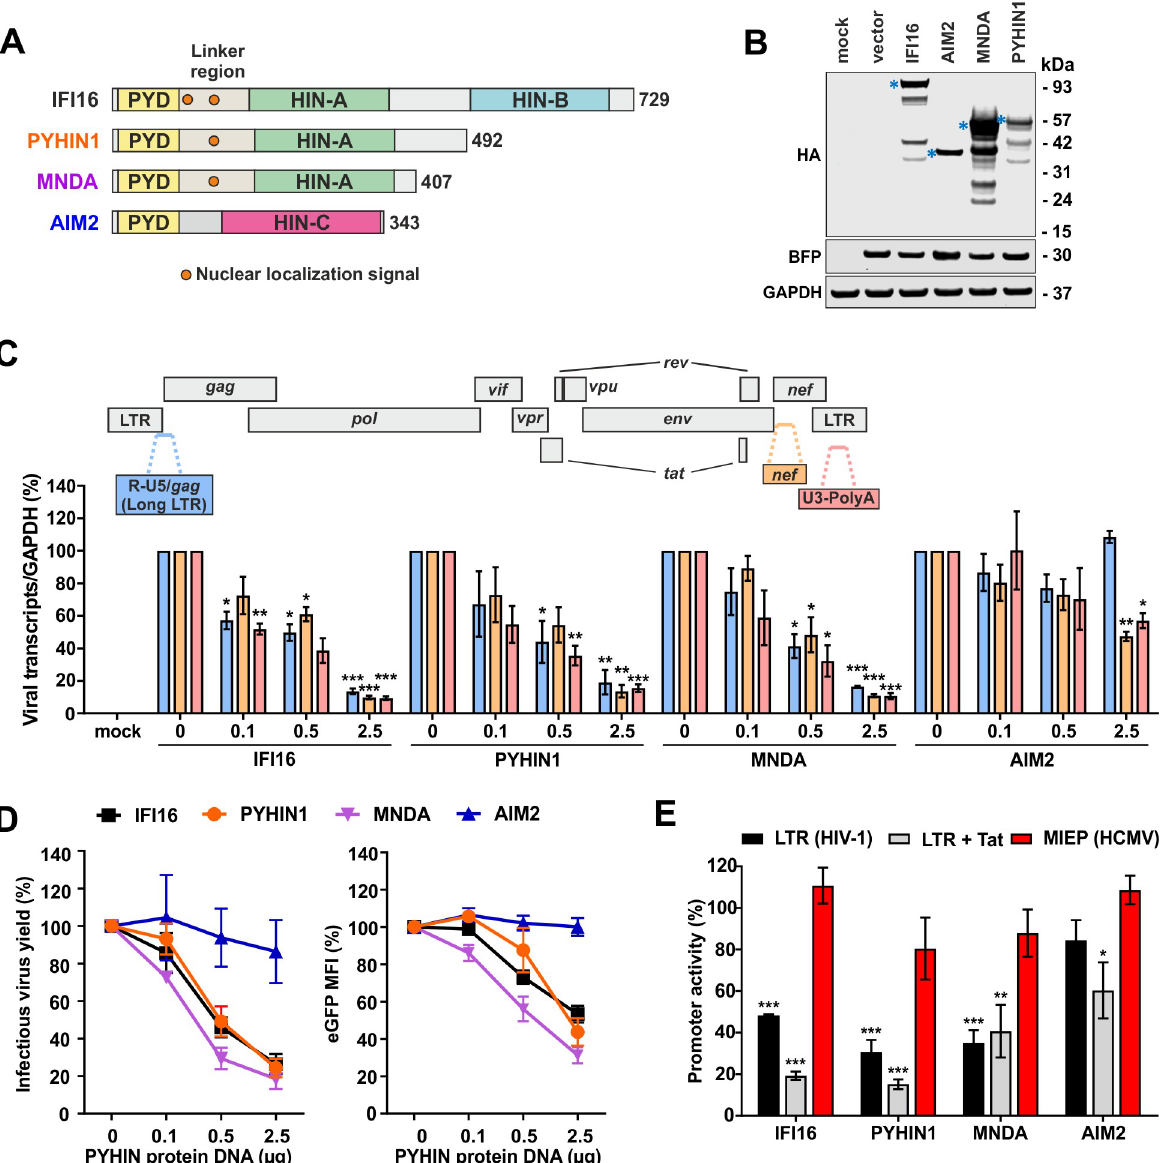
Fig 1. Nuclear human PYHIN proteins inhibit HIV-1 transcription. (A) Schematic presentation of the domain structure of human PYHIN proteins. Numbers indicate amino acid positions. (B) Expression of human PYHIN proteins. HEK293T cells were transfected with IRES-GFP constructs expressing the indicated HA-tagged PYHIN proteins. GFP and GAPDH were used as controls. Stars indicates bands of the expected size. (C) Levels of indicated viral transcripts in HEK293T cells cotransfected with increasing doses of expression constructs for IFI16, MNDA, PYHIN1 and AIM2 and constant quantities of the proviral HIV-1 NL4-3 construct determined by qRT-PCR in multiplex reactions. Data show mean percentages ( ± SEM; n = 3) relative to those detected in the presence in the empty control plasmid (100%). � p < 0.05, �� p < 0.01, ��� p < 0.001. Primers and probes were designed as previously described [65]. (D) Infectious virus yields in cell supernatants (left) and levels of LTR- dependent eGFP expression (right) in HEK293T cells transfected with vectors coexpressing the indicated PYHIN proteins and eGFP and the proviral HIV-1 NL4-3 IRES-eGFP construct were determined by TZM-bl cell infection assay and flow cytometric analysis at two days post- transfection. (E) HEK293T cells were cotransfected with luciferase reporter constructs under the control of the indicated promoters (MIEP, major immediate early promoter) and expression constructs for IFI16, PYHIN1, MNDA and AIM2 or a vector control. A construct expressing NL4-3 Tat under the control of the CMV IE promoter was used to activate the LTR. Shown are mean values ( ± SEM) measured in the presence of PYHIN proteins relative to the vector control (100%) obtained in three